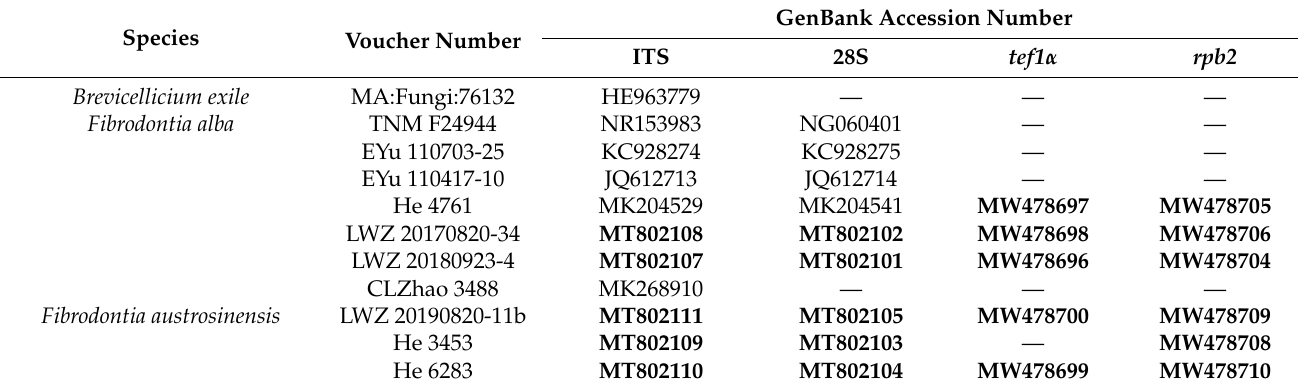
Table 1. Sequences used in the phylogenetic